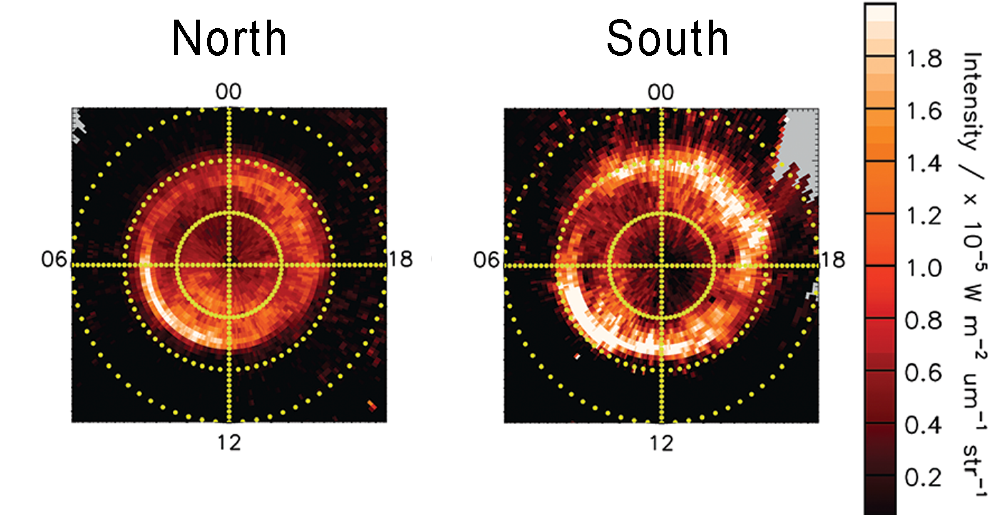
Figure 6. Polar projections of Saturn’s infrared aurora by the Cassini spacecraft’s Visual In- frared Mapping instrument. Two infrared channels were averaged together to produce the data: 3.532 ± 0.0161 µ m and 3.667 ± 0.0184 µ m, such that the majority of emissions are from H + figure from